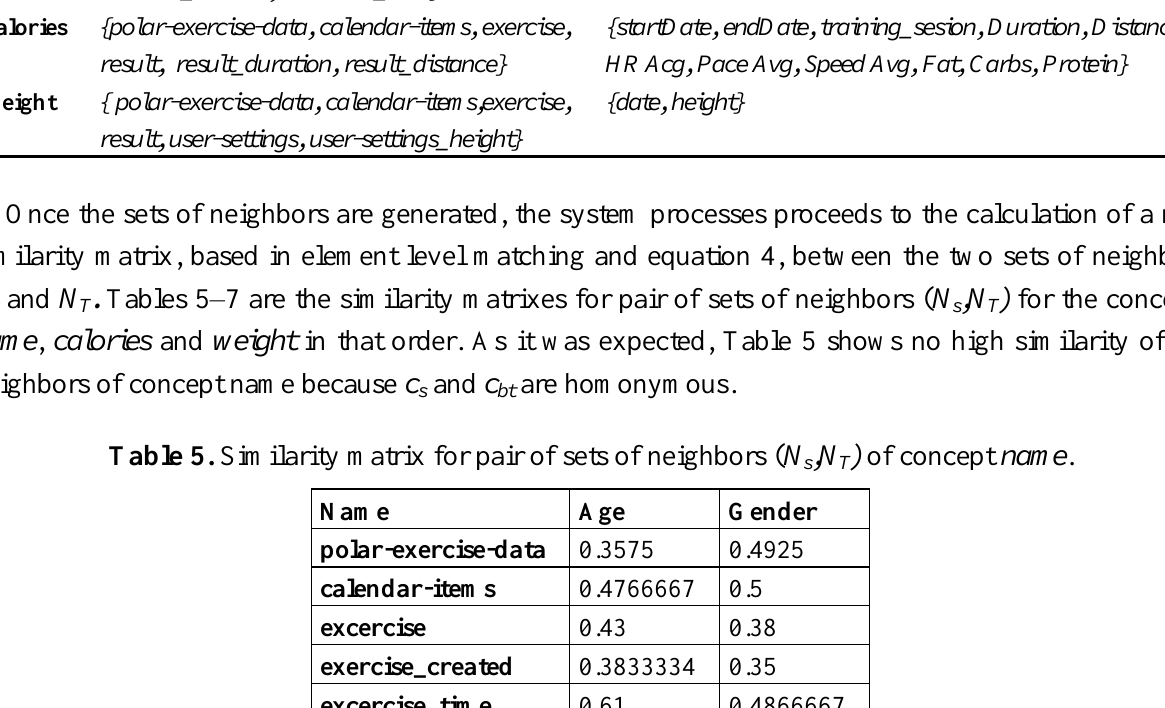
Table 6. Similarity matrix for pair of sets of neighbors ( N